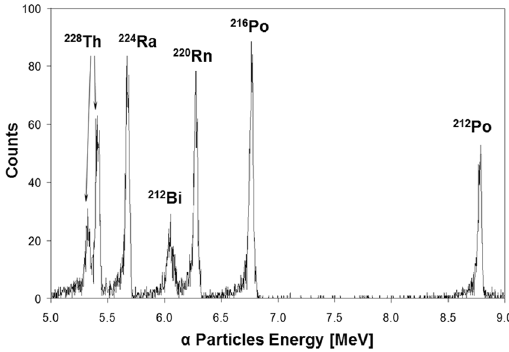
Figure 2. α -spectrum of the PbS ( 228 Th) sample grown at pH 12.8. Acquisition duration was 6 hours, at a distance of 16 mm from the